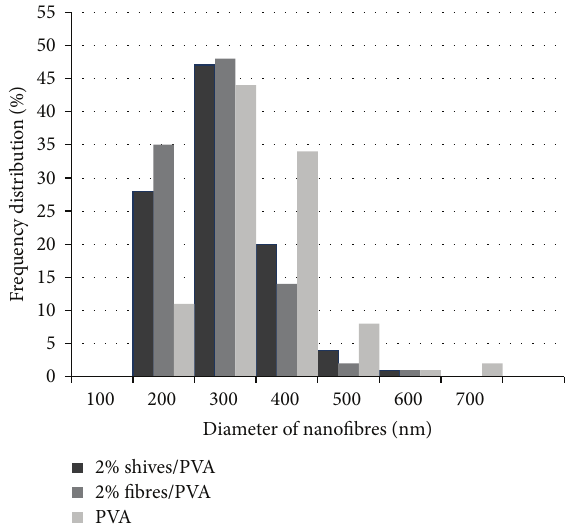
Figure 5: Diameter distribution of nanofibres from PVA, shives/ PVA, and fibers/PVA.